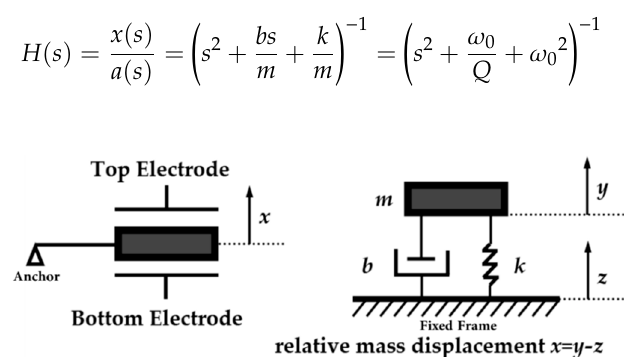
Figure 1. Schematic diagrams of a capacitive accelerometer structure and its mechanical lumped parameter model.